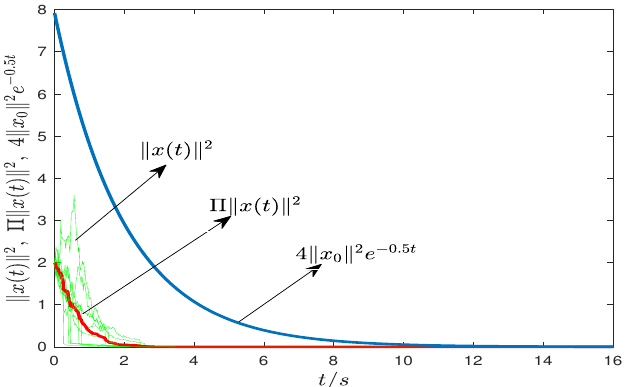
Figure 4. State trajectory curve of closed-loop system (25) for the SFC case.